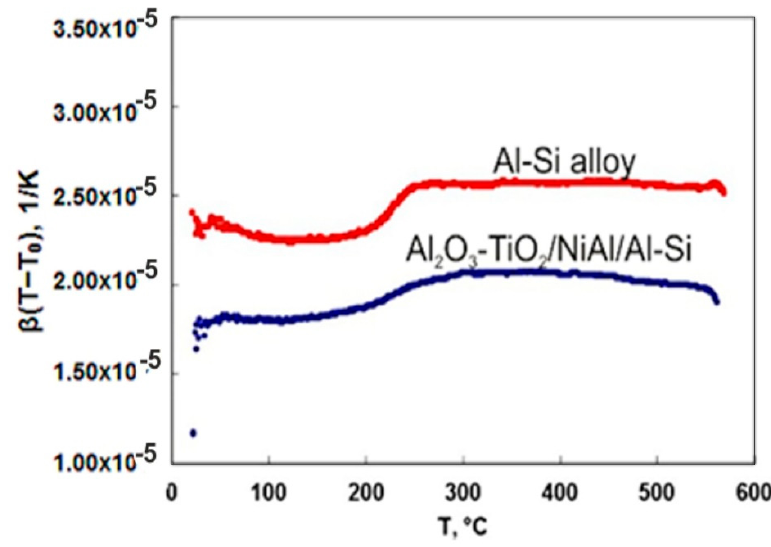
Figure 8. Comparison of changes in linear expansion coefficient for the Al-Si alloy and the Al 2 O 3 -15 wt.%TiO 2 / NiAl / Al-Si coating system plotted in function of temperature.